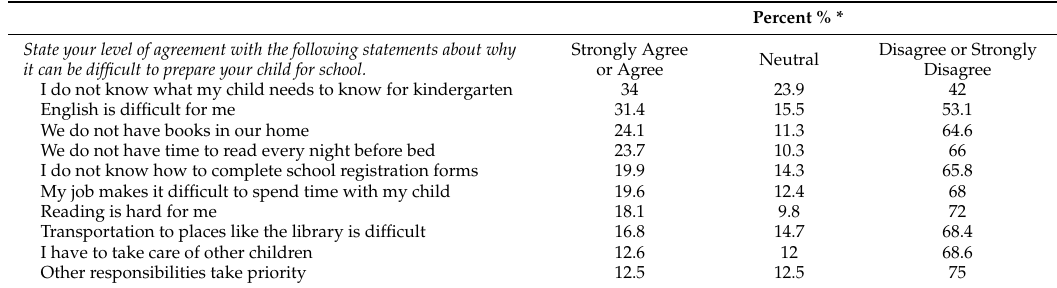
Table 2. Parent barriers to school readiness (n =